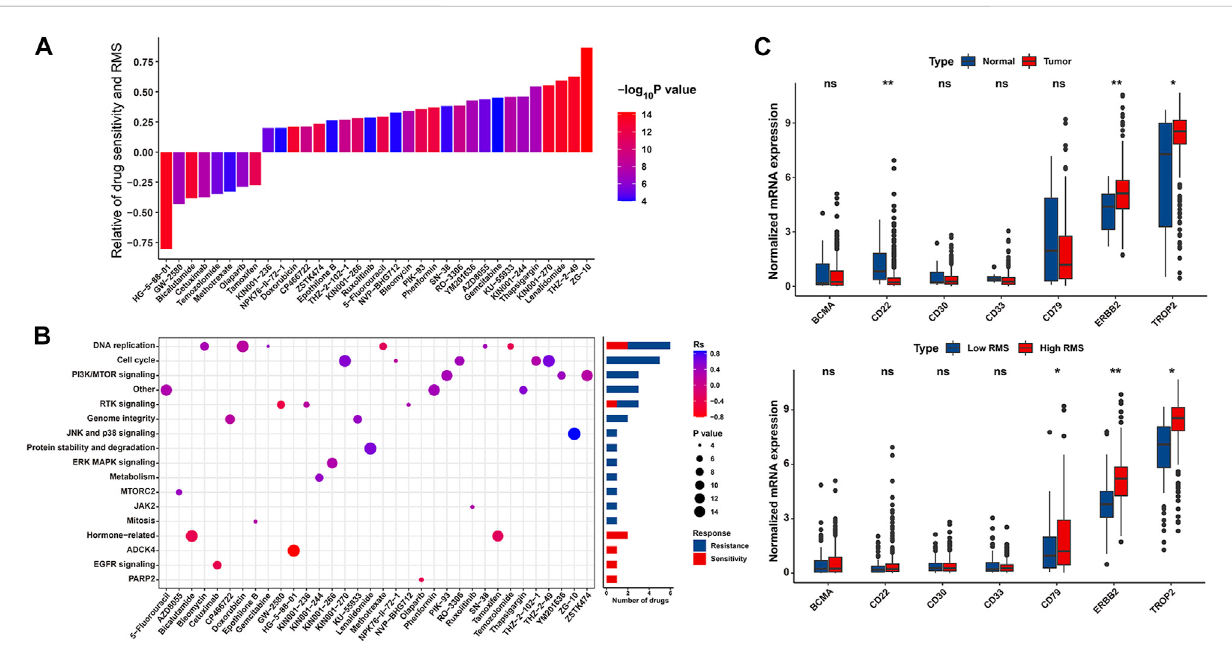
FIGURE 10 TheassociationbetweentheRMSandef fi cacyofantitumorchemotherapy. (A) SpearmancorrelationanalysisbetweentheRMSanddrugsensitivity. The columns represented drugs. The brightness and height represented the signi fi cance and degree of the correlation, respectively. Rs > 0.2 or Rs < − 0.2indicateddrugresistanceordrugsensitivity,respectively. (B) Barchartdisplayingsignalpathwaysassociatedwithdrugsthatwereresistant(Blue) orsensitive(Red)totheRMS. X and Y -axisdisplayeddrugnamesandcorrespondingsignalingpathways,respectively. (C) ViolinplotdisplayingmRNA levels of eight target antigens of ADC between normal tissues and BCa samples, and between RMS-low and -high BCa samples,